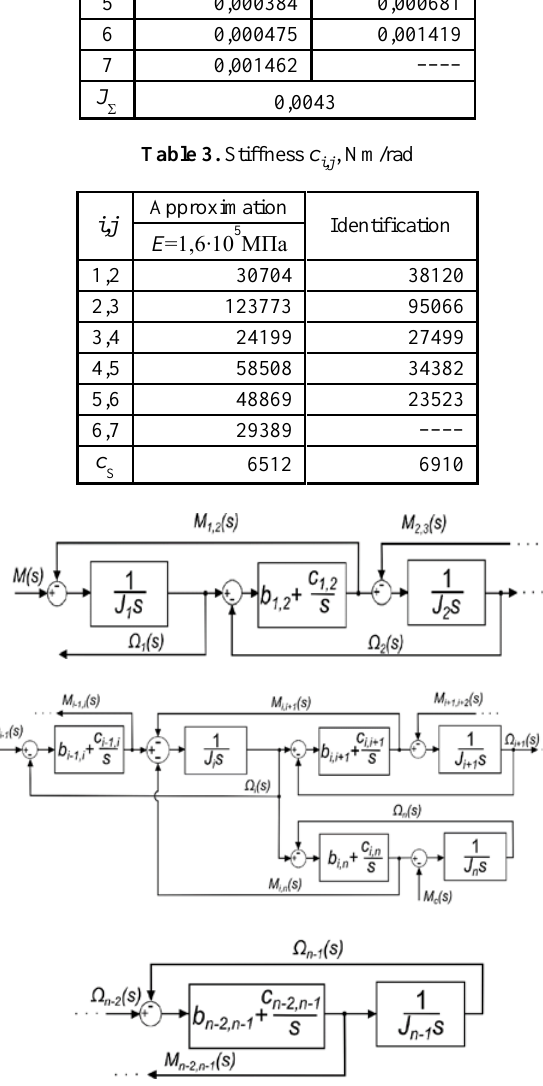
Figure 8. Multi-mass simulation model of the feed drive hardware.